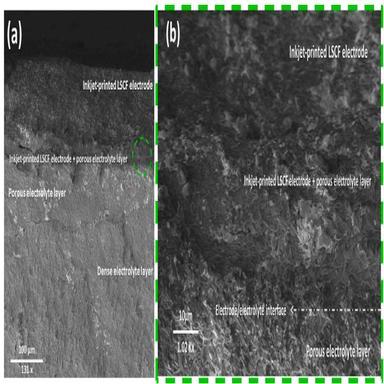
Cross-sectional SEM image of the inkjet-printed LSCF symmetric cell in a) low and b) high magnifications to give a better understanding of electrode adherence to the electrolyte.